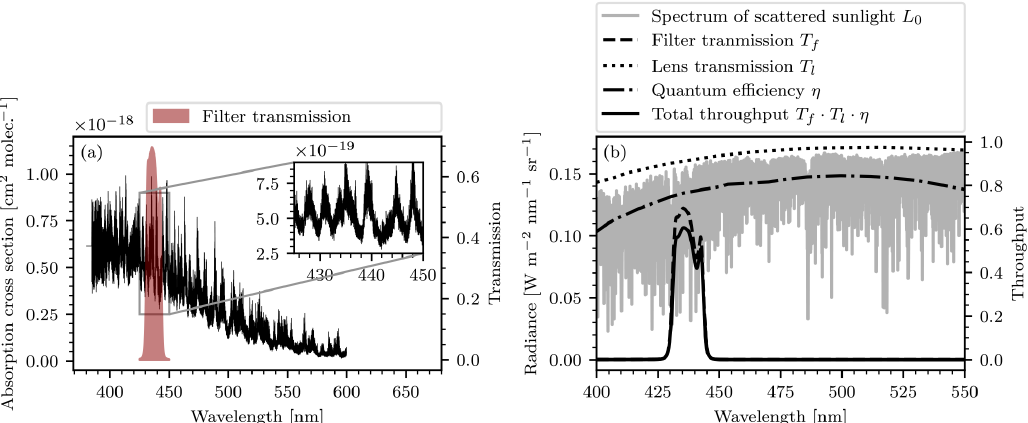
Figure 3. (a) The absorption cross section of NO 2 . The red filled region marks the transmission region of the bandpass filter used in our instrument. The inset in the top right shows a zoomed-in view of a spectral range that contains the filter transmission and shows highly structured absorption features. (b) The radiance spectrum, as well as the transmission lines of the filter T f and the lens T l , the quantum efficiency of the camera sensor η , and the total throughput T f · T l · η that are assumed in the instrument model.